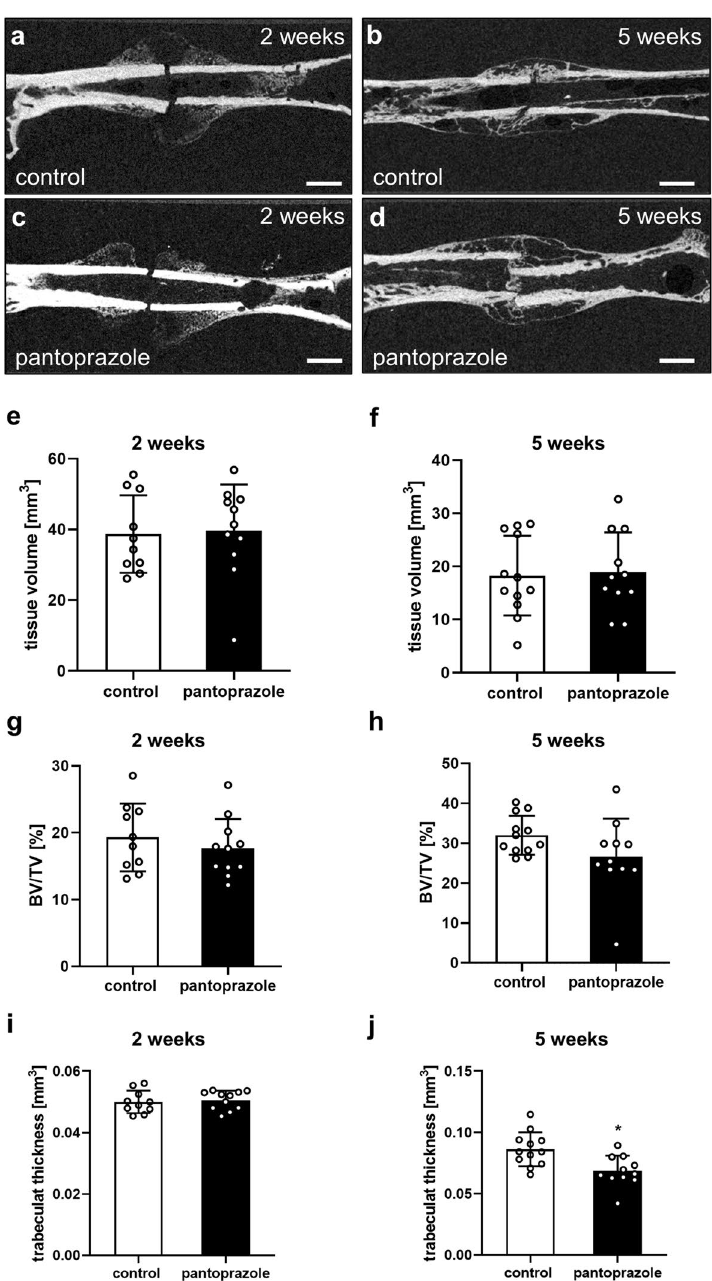
Figure 6. µ-CT analysis of mice femora. Representative µCT images at 2 weeks ( a , c ) and 5 weeks ( b , d ) after fracture healing in controls ( a , b ) and pantoprazole-treated animals ( c , d ). Scale bars: 2 mm. ( e – j ) µCT analysis of the tissue volume [mm 3 ] ( e , f ), bone volume/tissue volume ( BV/TV , [%]) ( g , h ) and trabecular thickness [mm] ( i , j ) at 2 weeks ( e , g , i ) and 5 weeks ( f , h , j ) after fracture healing in controls ( white bars ) and pantoprazole-treated animals (black bars). Means ± SD; n = 10–12; *p < 0.05 vs.